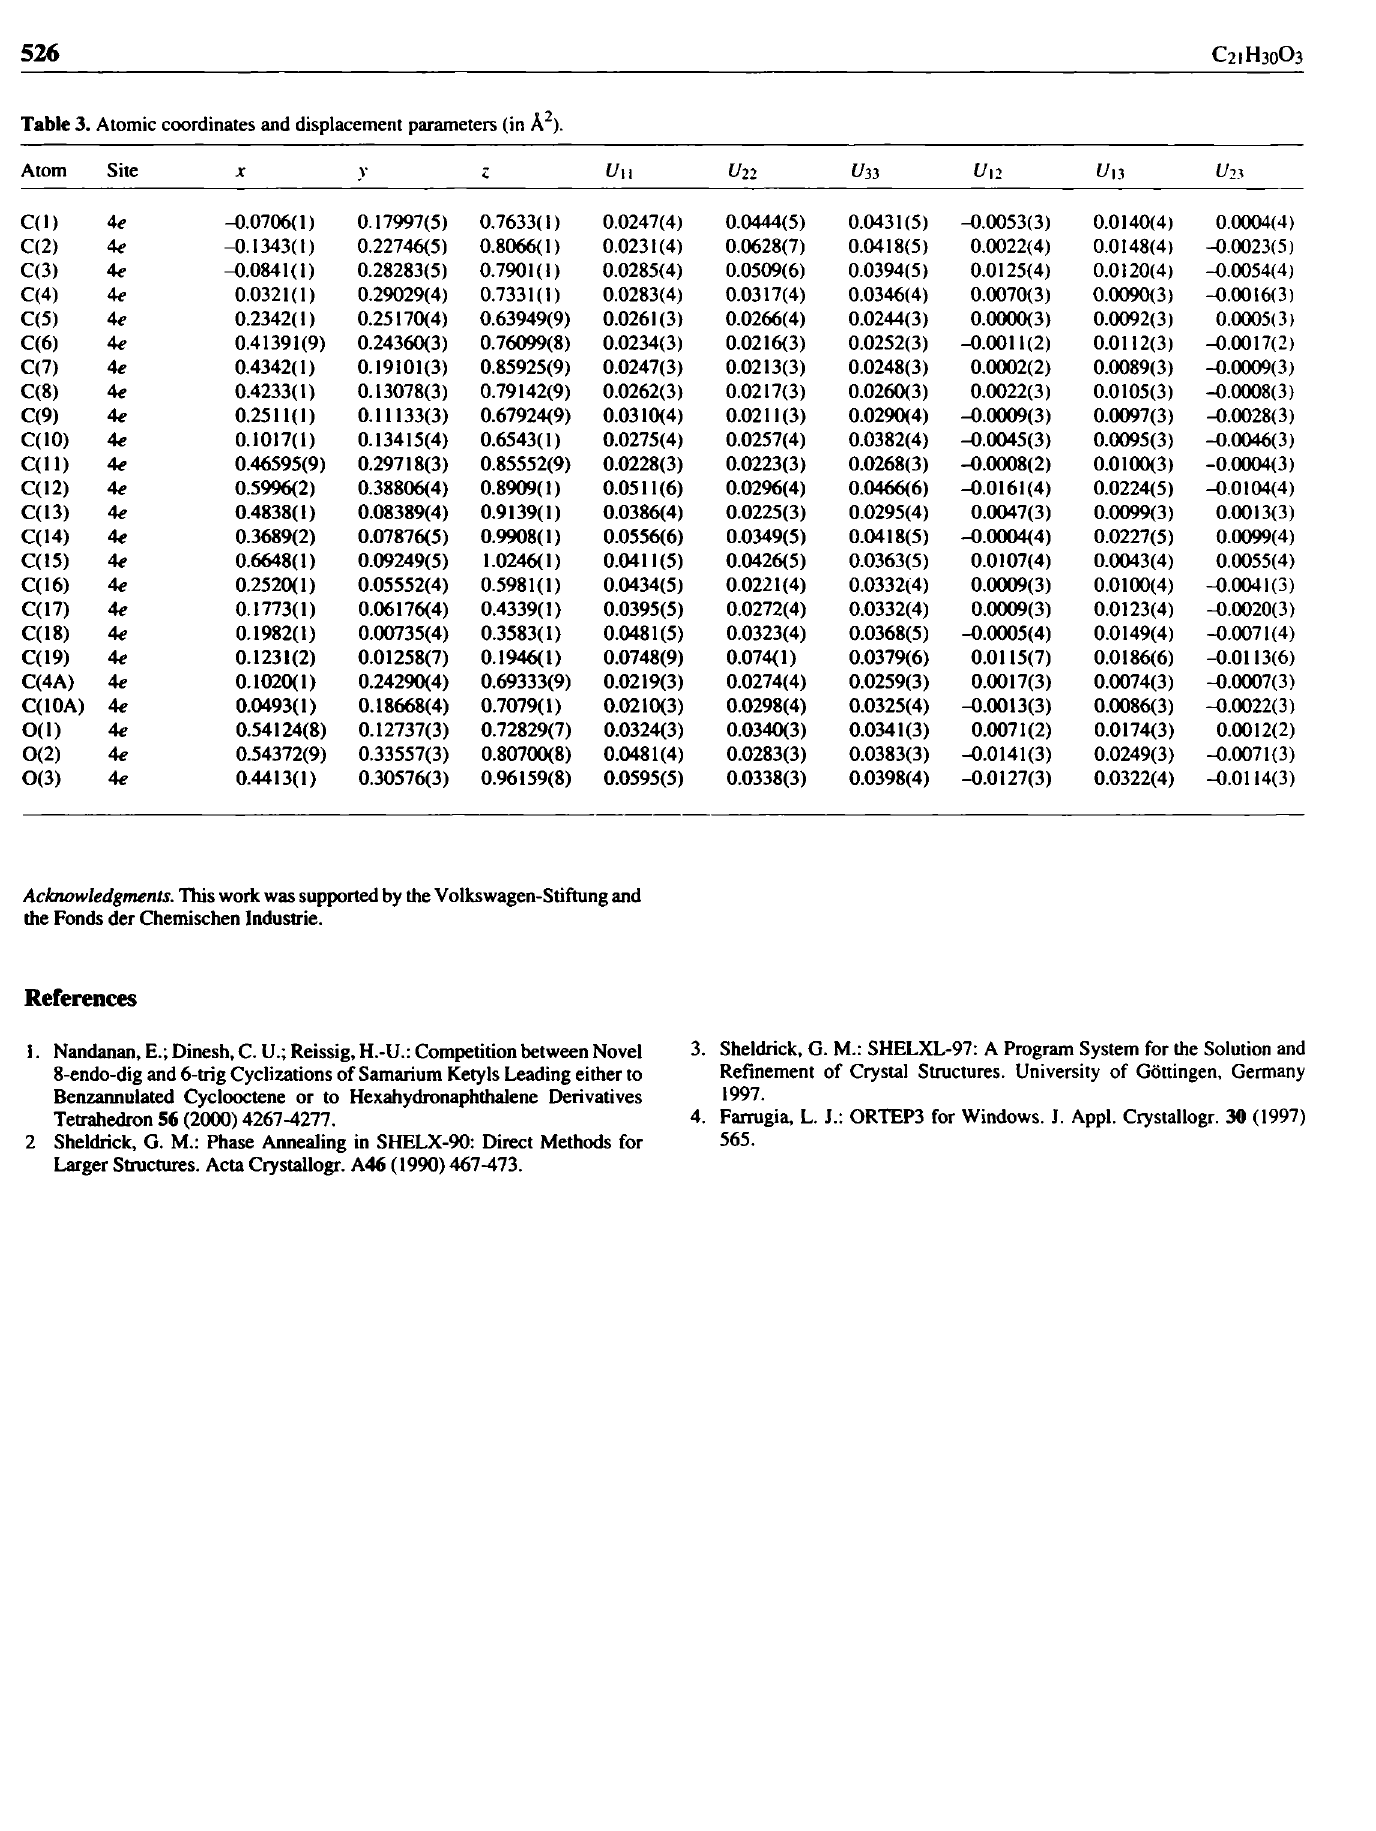
Table 3. Atomic coordinates and displacement parameters (in A 2